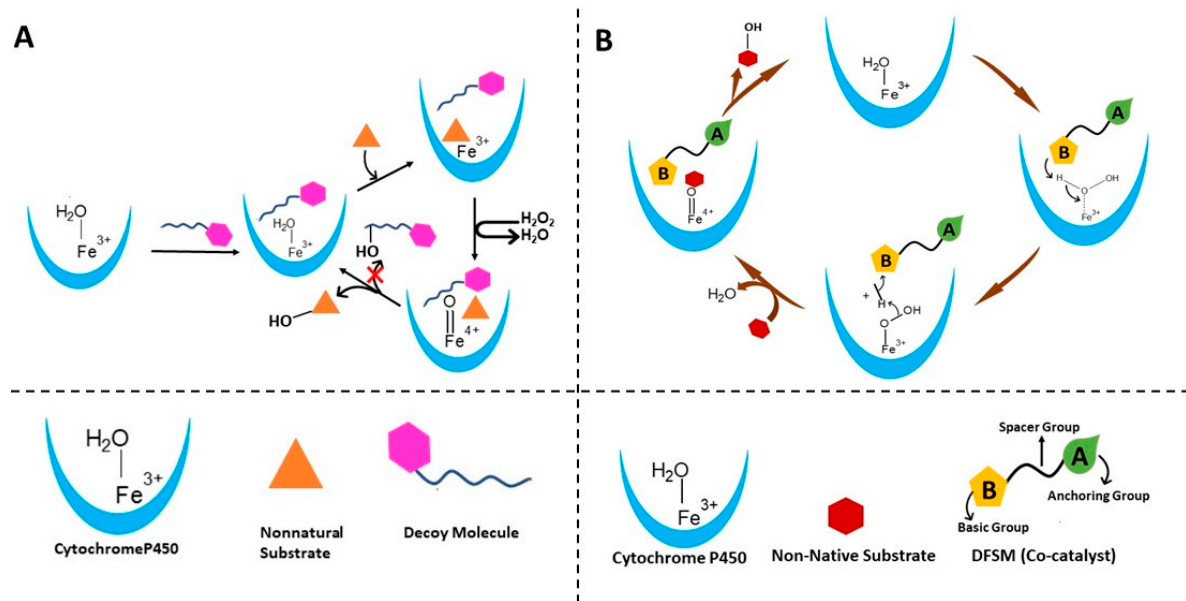
Figure 7. Schematics of different strategies used to tune the P450 enzymes to catalyze the H 2 O 2 - dependent oxidation reactions. ( A ) Strategy for oxidation of nonnatural substrates in the presence of decoy molecule by Cytochrome P450. This involves the addition of a dummy substrate to accom- modate non-natural substrate by remolding the active site. ( B ) DFSM co-catalysis strategy that in- volves the addition of a co-catalyst to aid the NADPH-dependent Cytochrome P450 for activation of the peroxide pathway for the catalysis of reactions of non-native substrates.